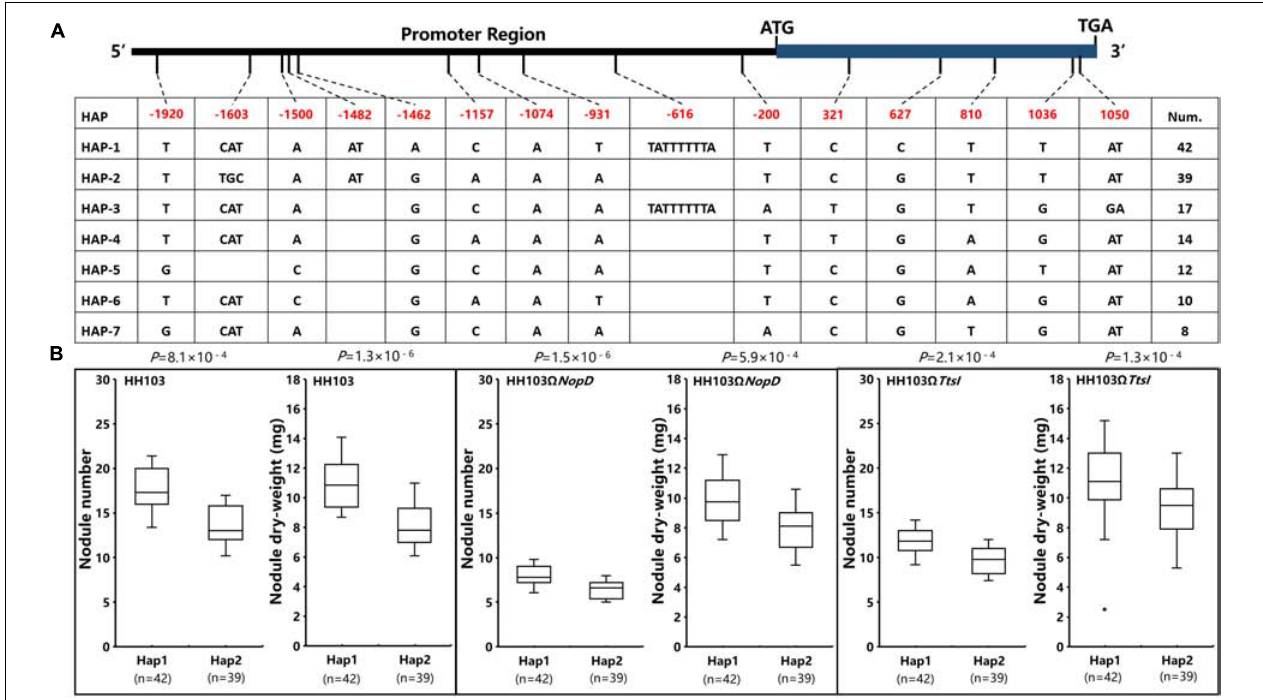
FIGURE 7 | The analysis of Gm19g069200 haplotypes and nodule traits in two Hap accessions. (A) Gm19g069200 gene haplotypes (seven haplotypes) in chromosome segment substitution line (CSSL) populations ( n = 142). The start codon site is set at “0” position. (B) Comparison and analysis of the nodule phenotype between haplotypes Hap1 ( n = 42) and Hap2 ( n = 39). n represents the number of the two haplotypes. Two-tailed t -test was used to detect the